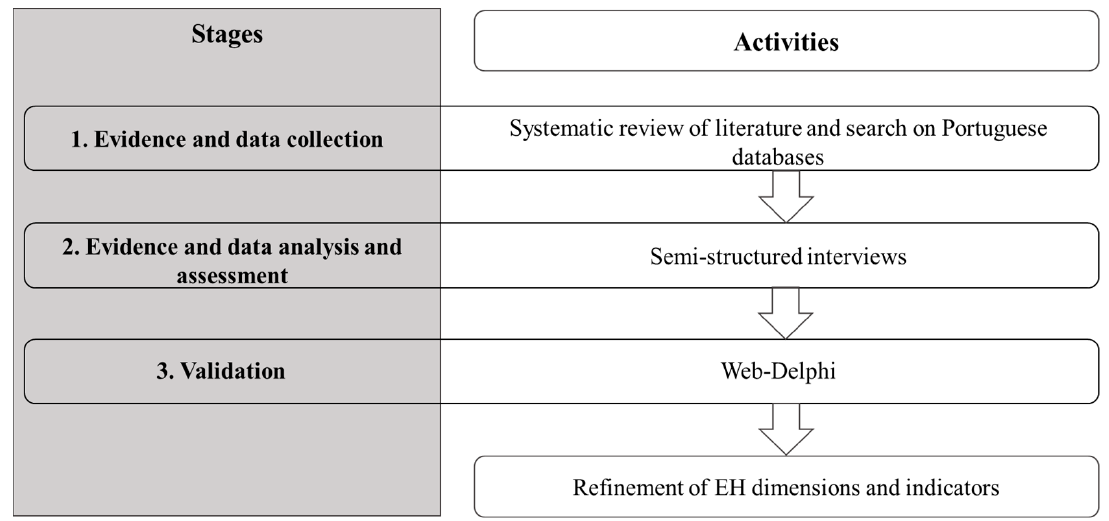
Figure 1. Overview of the approach used to select the key dimensions and indicators, from built and natural environment determinants, to evaluate environmental health (EH) in the Lisbon urban setting.